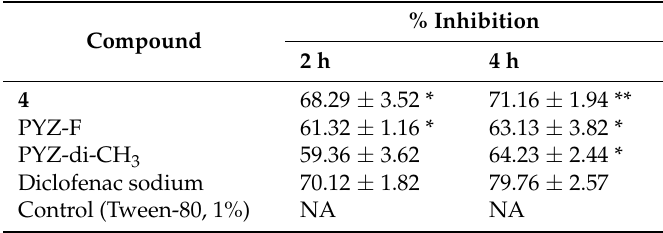
Table 1. Anti-inflammatory activity of compound 4 and its analogues.